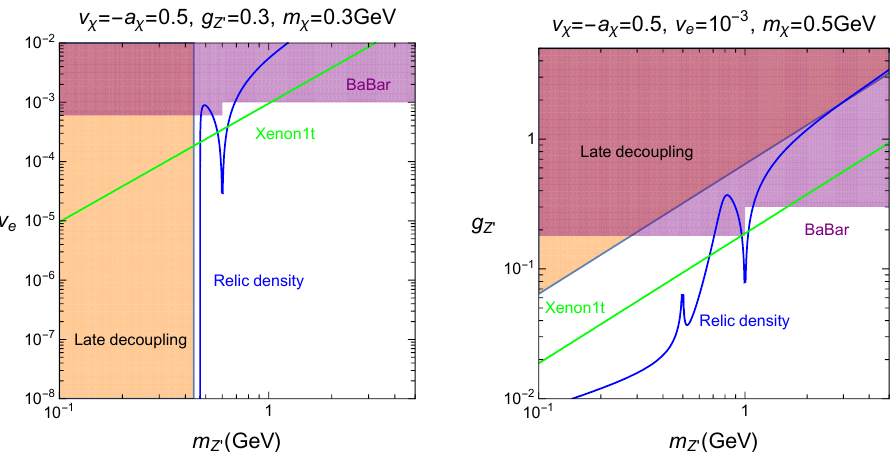
Figure 2 . Parameter space for relic density and XENON1T electron excess. The favored region by XENON1T electron excess is along the green line, the relic density is satisfied along the blue line. The purple region on the left plot is excluded by the BaBar limits on the visible and invisible decays of Z 0 . We have taken v χ = − a χ = 0 . 5 , a e = 0 , and m χ = 0 . 3 , 0 . 5 GeV on left and right plots, respectively, and g Z 0 = 0 . 3 on left and v e = 10 − 3 on right. In the orange region, the relic density for the heavier state is Boltzmann-suppressed for T kd = 1 MeV